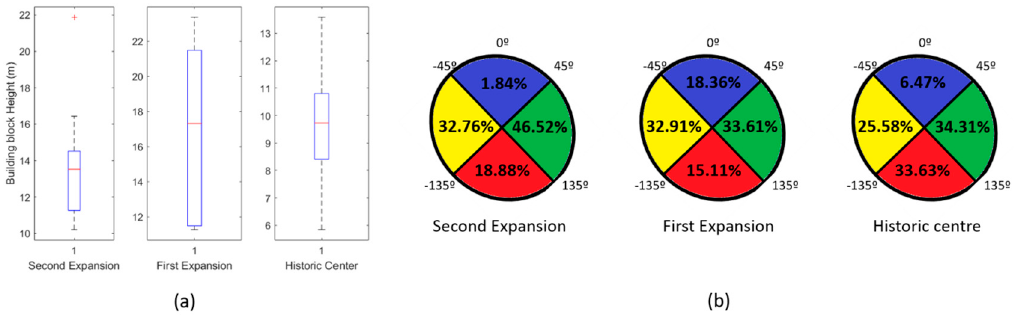
Figure 10. ( a ) Comparison of building block heights for the three case study areas, ( b ) comparison of façade orientation, having in account the four orientation labels that were defined for each point.